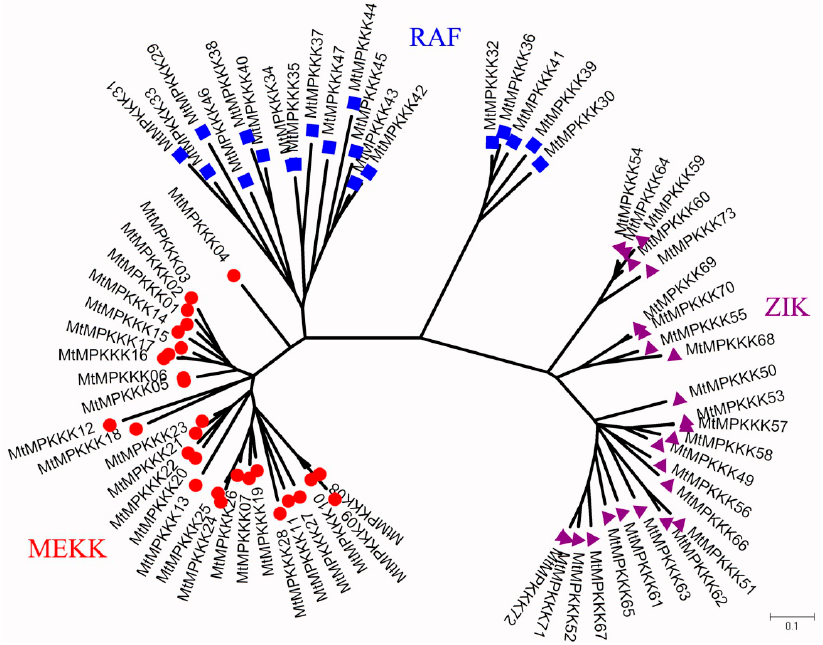
Figure 2. Phylogenetic tree analysis of the MAPKKK gene family in Medicago truncatula .